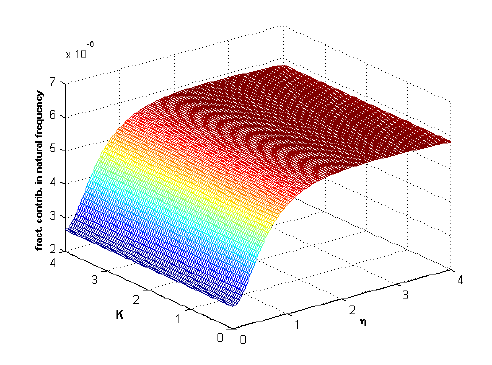
Figure 10. Fractional contribution frequency versus stiffness K and nonlocality η ( α = 0.2).